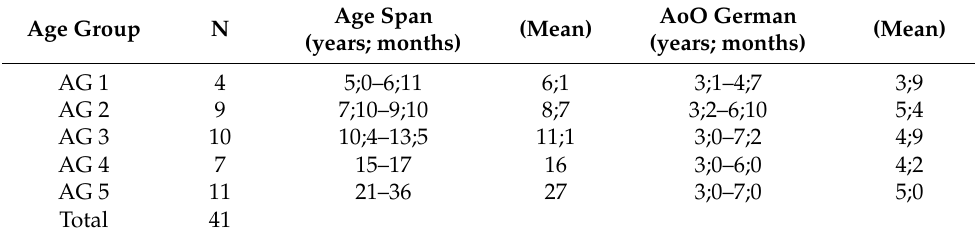
Table 2. Early sequential bilinguals included in the study.